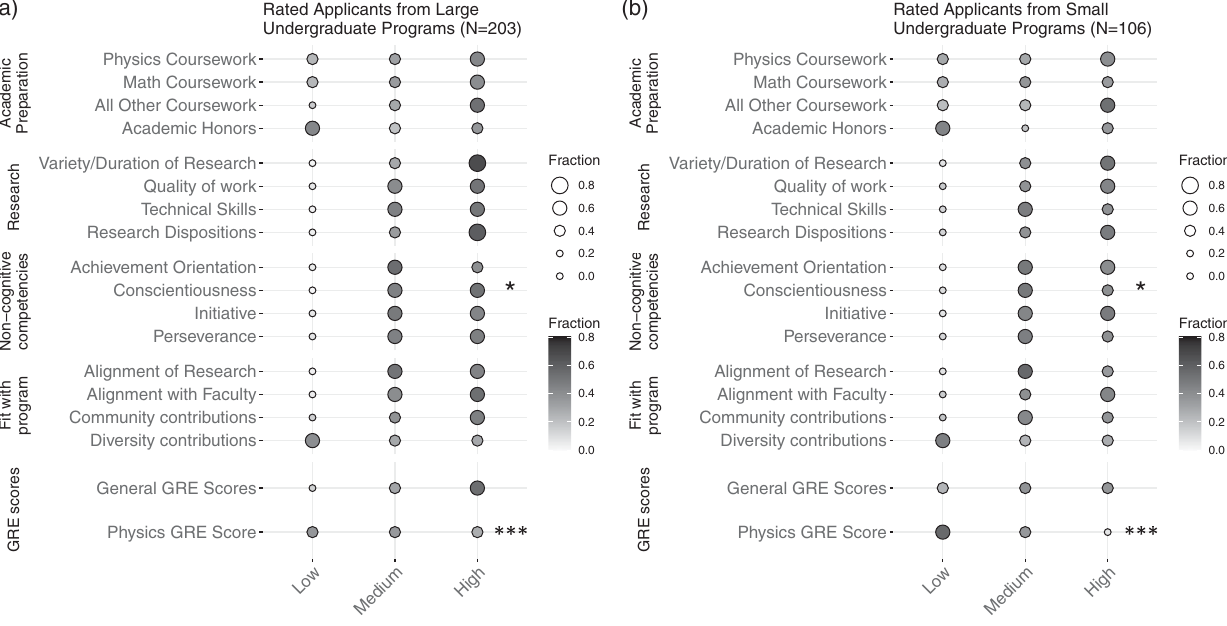
FIG. 5. Faculty ratings of domestic applicants (admitted and nonadmitted) on 18 constructs split by whether the applicant attended a university with a larger or smaller physics program. Ratings that are statistically different between the two plots are marked on the right side of the plot, with a corrected p value < 0 . 001 represented by ***, < 0 . 01 by **, and < 0 . 05 by *. Only the physics GRE score and conscientiousness showed differences between the groups of applicants, with the latter dependent on how larger physics program is